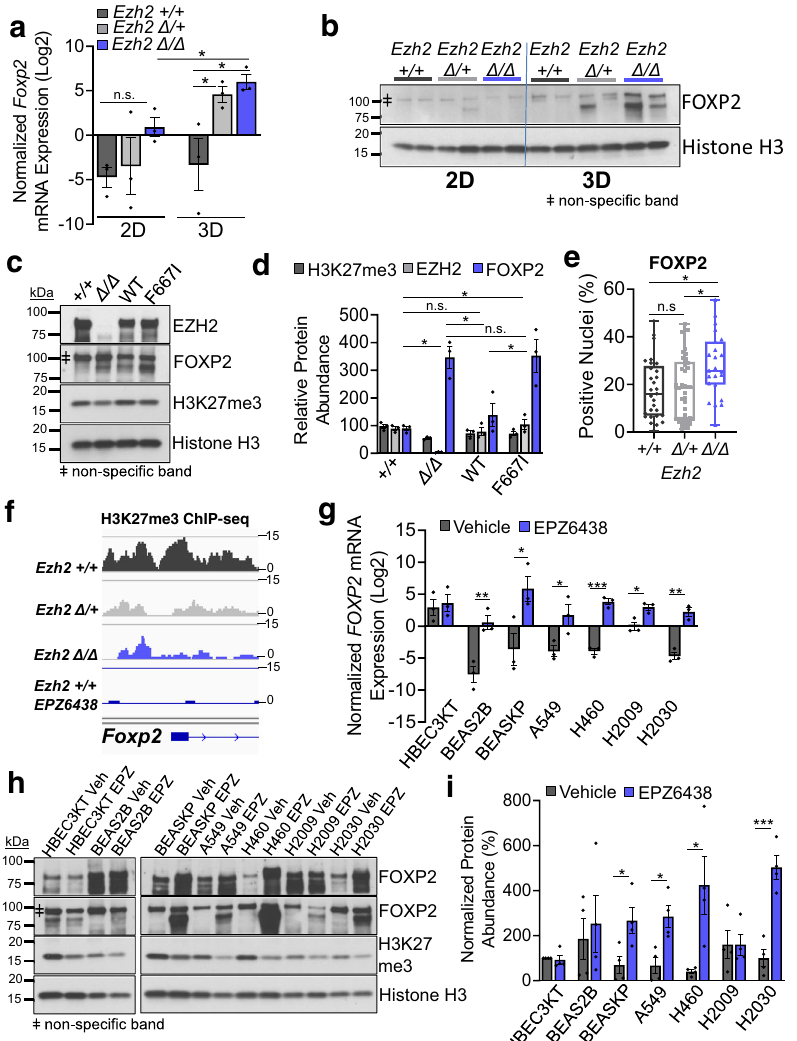
Fig. 4 | LossofPRC2 activitydrivesincreased FOXP2 expressionin normal and malignant lung cells. a Relative expression of Foxp2 mRNA in mouse primary 2D tumorcellsand3Dtumorspheroidswiththeindicated Ezh2 genotypesgraphedas mean values +/ − SEM. * indicates P <0.043 by one-way ANOVA with multiple comparisons and Holm – Š ídák ’ s post hoc test between genotypes and two-tailed t test between conditions. n =3 individual mouse tumor-derived cultures per gen- otype/culturesystem. b FOXP2proteinexpressionin2Dcellsand3Dtumoroidsof the indicated Ezh2 genotypes was examined by immunoblot. Total histone H3 is the same as Fig. 2e. ǂ indicates the non-speci fi c band seen with FOXP2 antibody from CellSignaling Technologies. c Immunoblot and d the normalizedabundance of the indicated proteins in Ezh2 WT, Ezh2 null, Ezh2 null with WT Ezh2 re- expression (WT), and Ezh2 null with F667I-mutant Ezh2 re-expression (F6771). Quanti fi cation data are plotted as mean values +/ − SEM. * indicates P <0.0261 by one-way ANOVA with multiple comparisons and Holm – Š ídák ’ s post hoc test. n =3 individualblotting experiments from two cellcultures. e Percentages of positively stainedtumornucleiforFOXP2inthetumorsoftheindicatedgenotypesplottedas box-and-whisker plots, error bars are min – max, box bounds are 25th and 75th percentiles and center line is median. * indicates P =0.0233 by one-way ANOVA